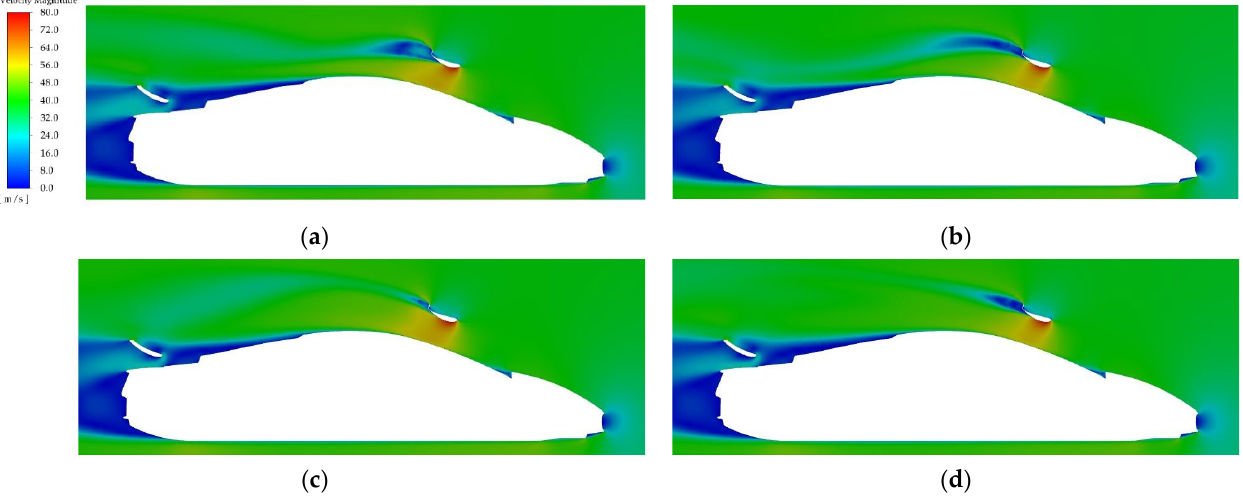
Figure 37. Velocity magnitude contours on a symmetry plane, showing a sequence of images over an oscillation cycle T : ( a ) T /4; ( b ) T /2; ( c ) 3/4 T ; ( d ) T .